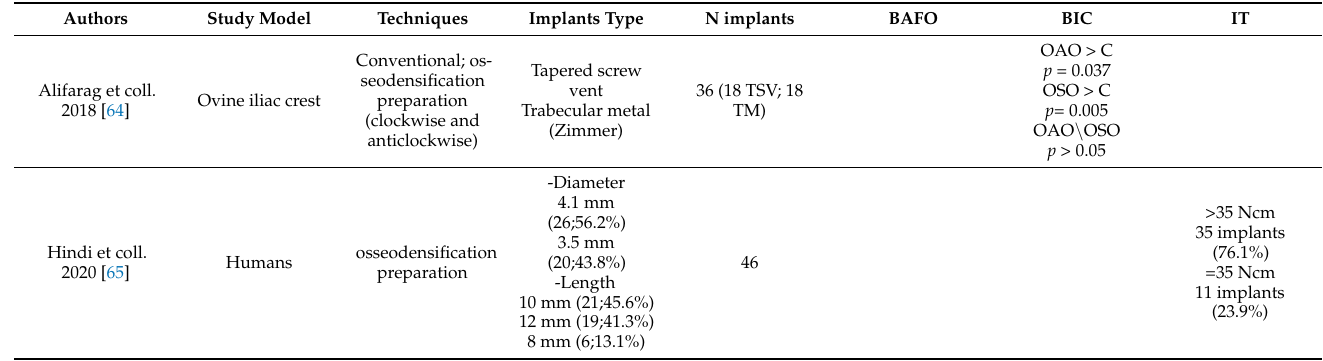
Table 2. Comparison of the papers analyzed according to the choice of the sample of these studies, the techniques used, the model and type of implants, the results obtained. BAFO, bone area fraction occupancy; BIC, bone-implant contact; IT, insertion torque; OD, osseodensification technique through alveolar preparation, OSO, osseodensification technique through alveolar preparation with drills used in a clockwise direction; OAO, technique of osseodensification through alveolar preparation used in an anticlockwise direction; C, conventional technique of alveolar preparation; CS, technique that uses Summers